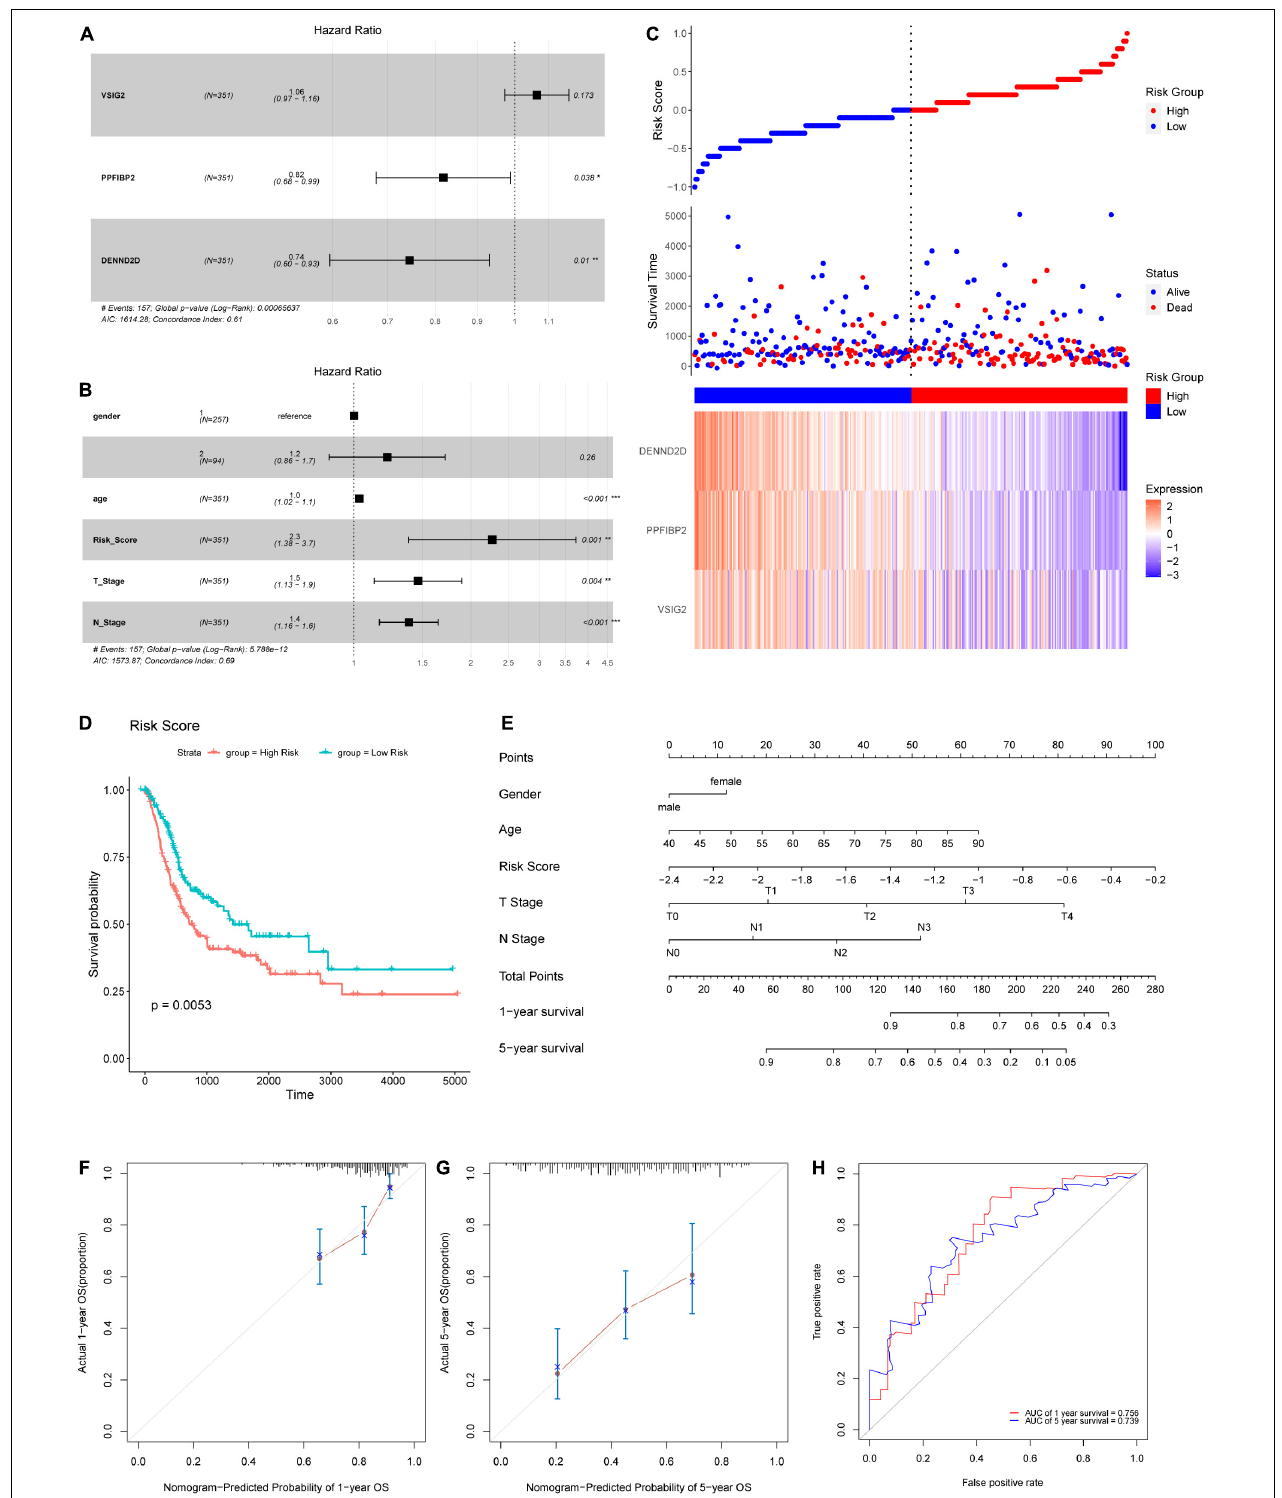
FIGURE 7 | (A) A Forest map of hub genes, as determined by multivariate Cox regression analysis. (B) A Forest map of risk score and other clinical features, as determined by multivariate Cox regression analysis. (C) Risk score distribution, survival status, and an expression heatmap for the three hub genes. (D) Kaplan-Meier survival curves for patients in the low- and high-risk groups. (E) Nomogram for predicting the 1- and 5-year OS of patients with BLCA. (F,G) A calibration curve of the constructed nomogram for predicting 1- and 5-year OS. (H) The time-dependent ROC curves for the constructed nomogram using the test data.